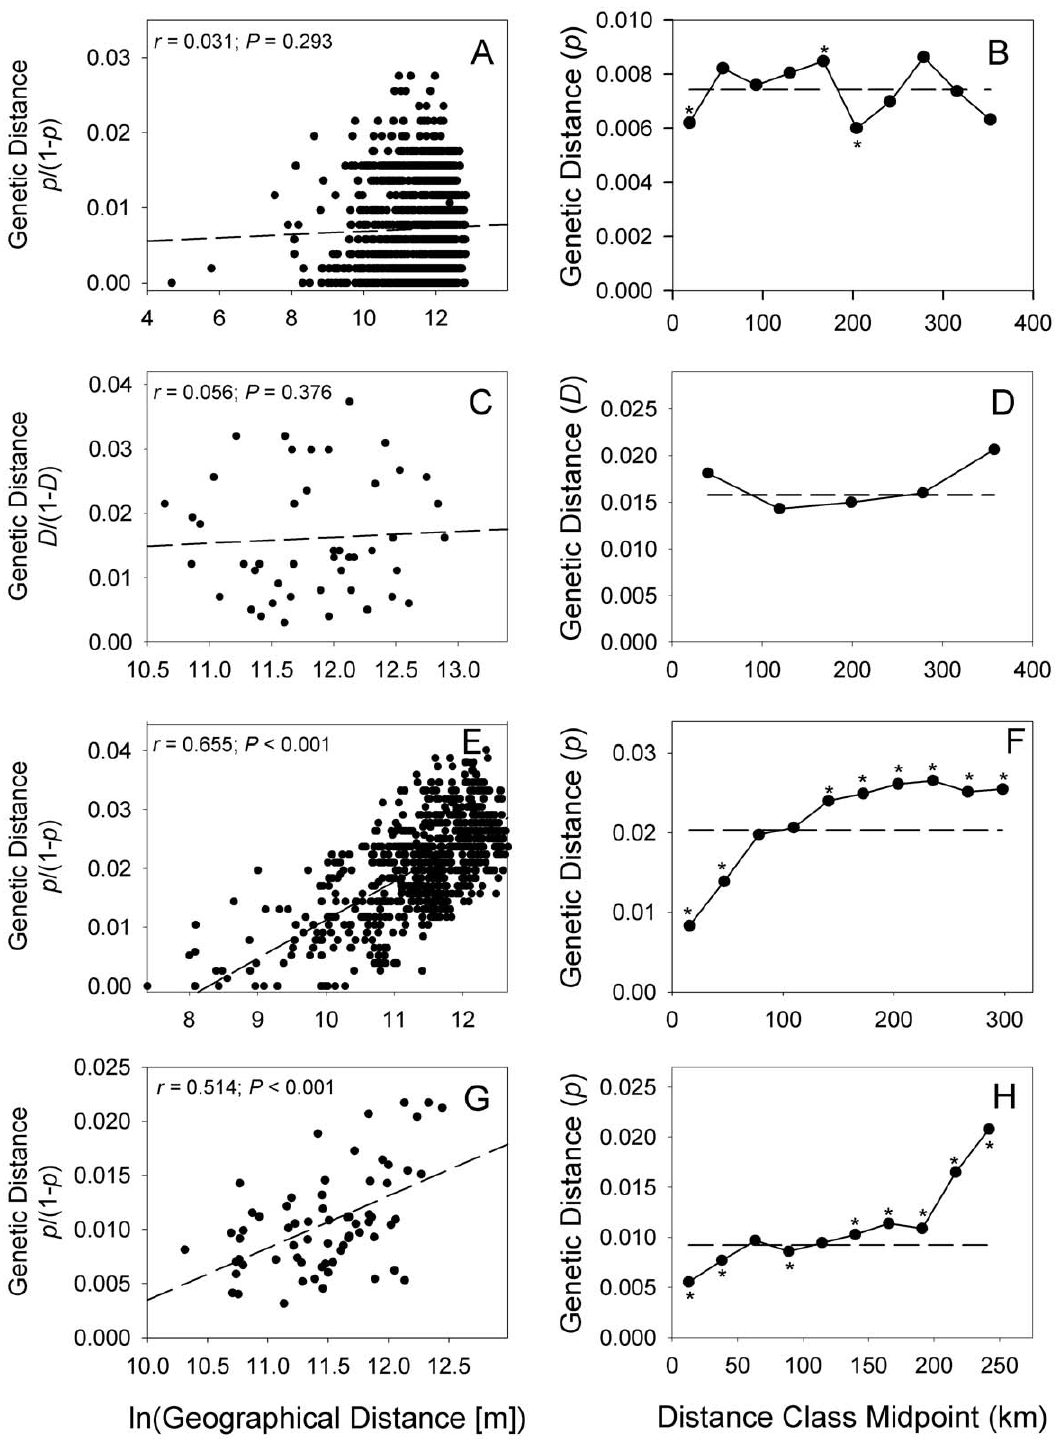
Figure 2. Results of Mantel tests (left column) and spatial autocorrelation analyses (right column) for four species investigated. Panels A and B: S. o. caurina . Panels C and D: P. monticola , Panels E and F: R. variegatus , Panels G and H: A. longicaudus . Distance classes in spatial autocorrelations that showed significantly larger or smaller values at the a =0.05 level than average (indicated by horizontal dashed lines) are marked with asterisks. doi:10.1371/journal.pone.0013683.g002 spatial genetic structure patterns (see Discussion). To investigate In the first stage, a spatially structured population was allowed to this process, we adopted a two-stage simulation procedure to evolve until patterns of diversity reached a quasi-equilibrium state explore spatial genetic patterns produced during range expansions. reflecting expected number of alleles and heterozygosity based on